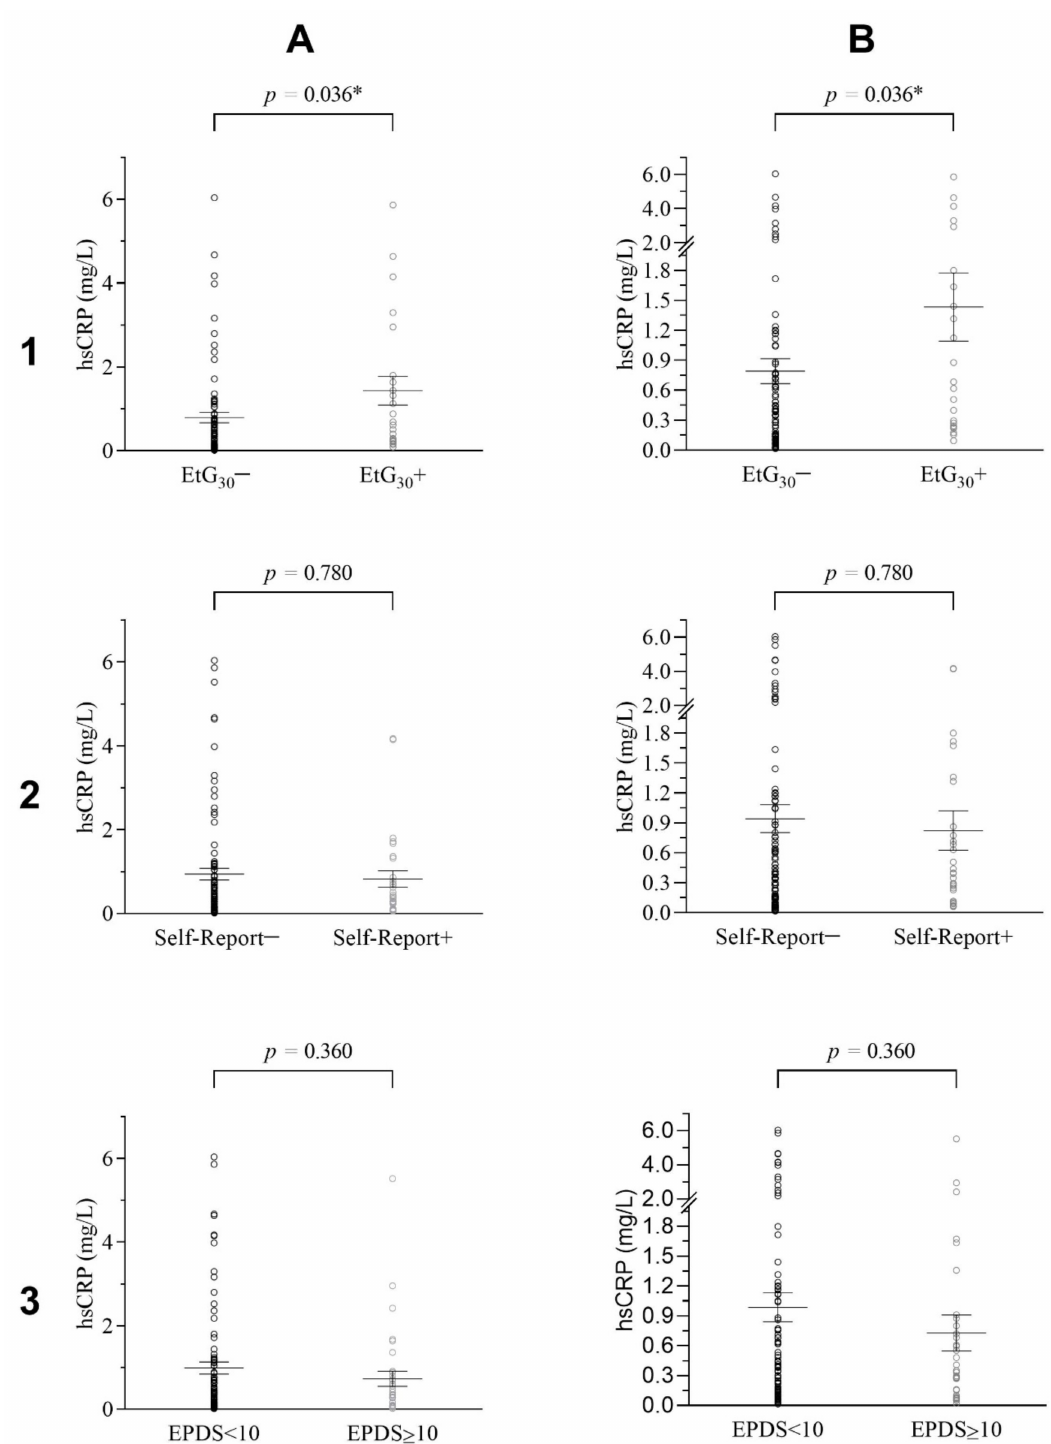
Figure 2. Distribution of Adolescent’s hsCRP Levels for EtG, Self-Report and EPDS Groups. ( 1 ), ( A ) Adolescent’s hsCRP levels grouped for EtG30+/EtG30 − as an overview and ( B ) with focus on lower levels of hsCRP ( n = 104). ( 2 ), ( A ) Adoles- cents hsCRP levels grouped for maternal self-report − /self-report+ on prenatal alcohol consumption and ( B ) with focus on lower levels of hsCRP ( n = 122). ( 3 ), ( A ) Adolescents hsCRP levels grouped for EPDS < 10 / EPDS > 10 and ( B ) with focus on lower levels of hsCRP ( n = 122). Error bars show standard errors; ANCOVA p -Levels assigned. * p <